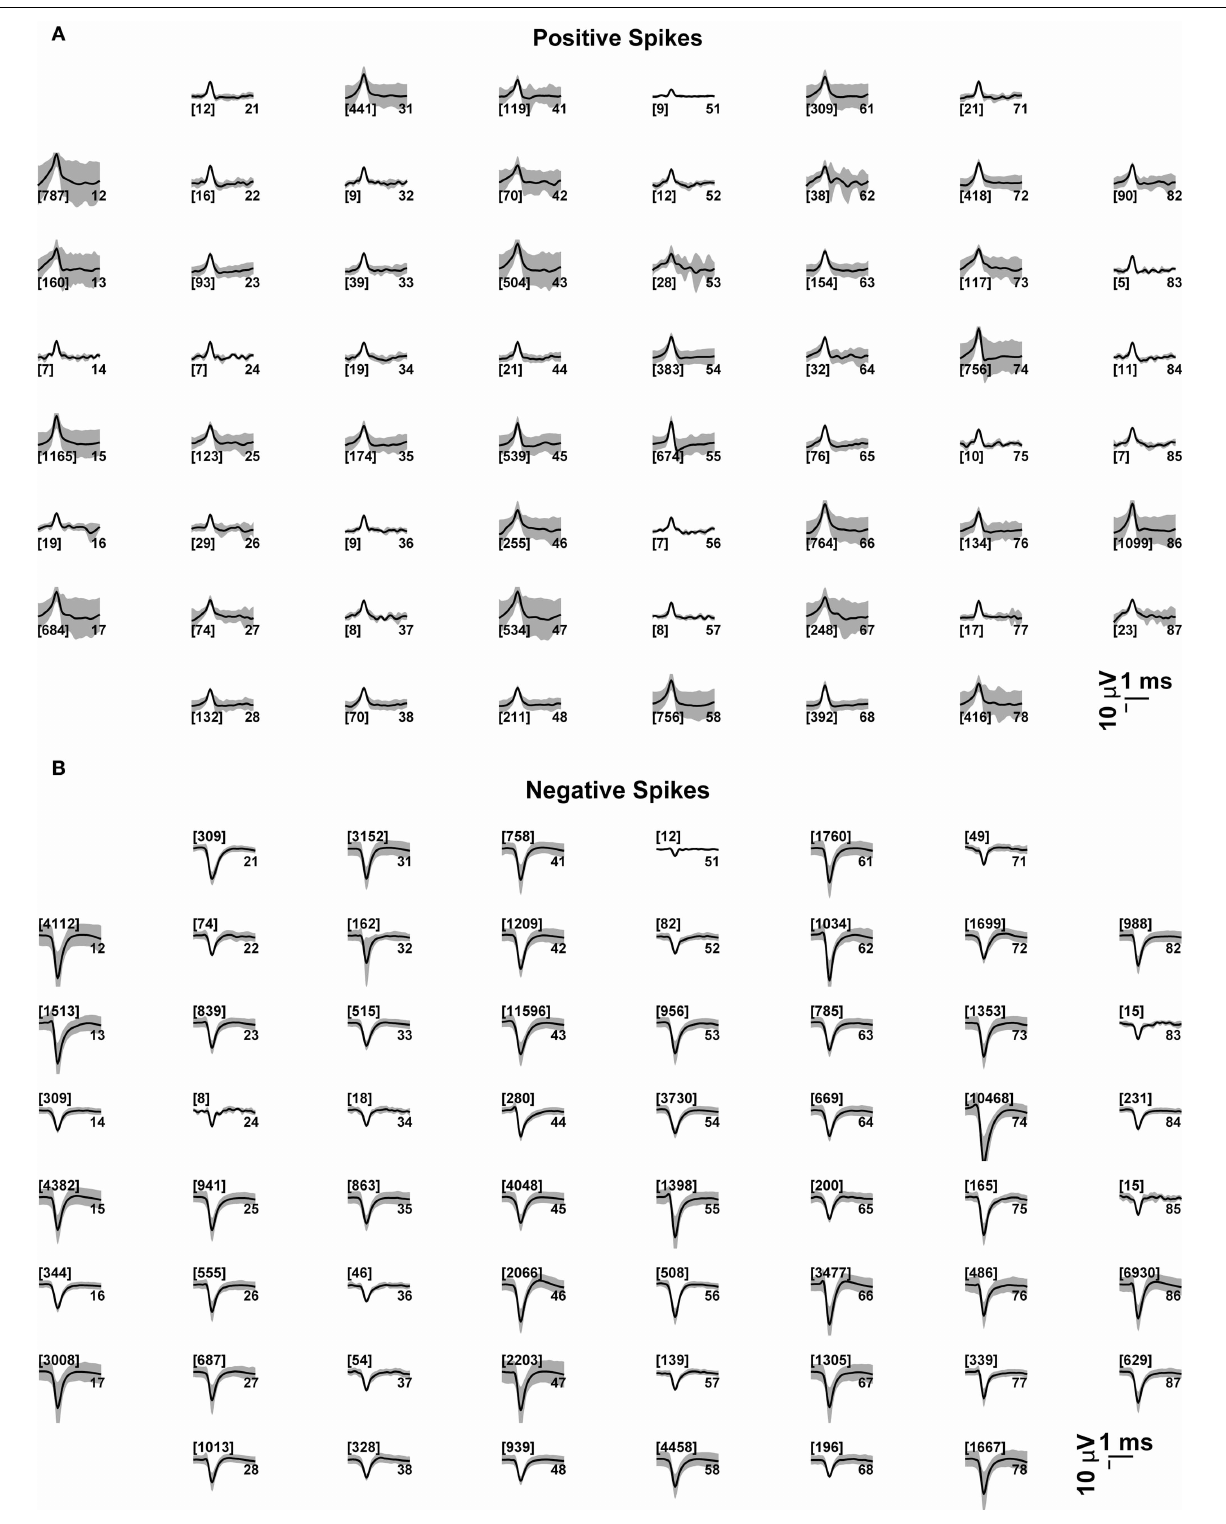
(B) threshold crossing events are displayed for each microelectrode, together with its point by point variability (gray shading, i.e., standard deviation), and with the number of events among brackets. The numbers on the right hand side of each subplot denote the labeled electrode